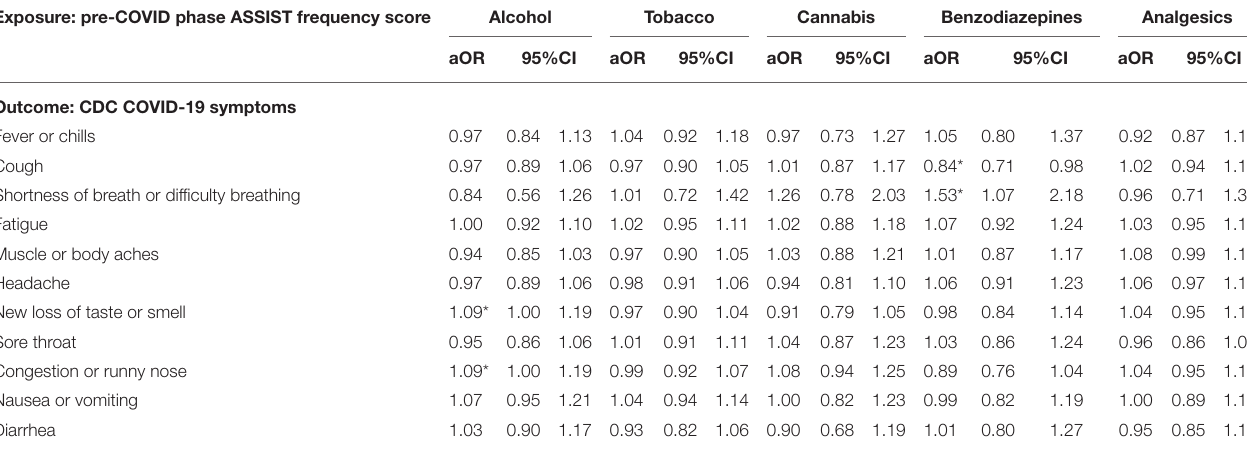
TABLE 2 | Results of the logistic regression model for CDC COVID-19 symptoms among 993 individuals who had mild COVID-19 in São Caetano do Sul, SP, Brazil. Exposure: pre-COVID phase ASSIST frequency